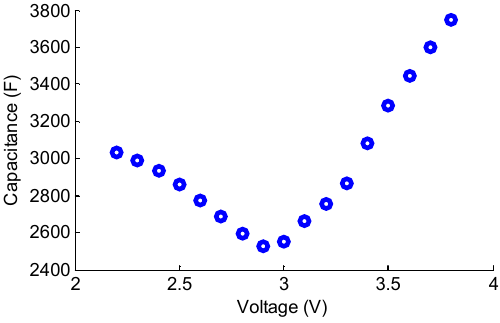
Figure 2. The nonlinear evolution of the capacitance of an asymmetric Lithium-ion Capacitor (LiC) (3300F, JSR Micro) with respect to its terminal voltage